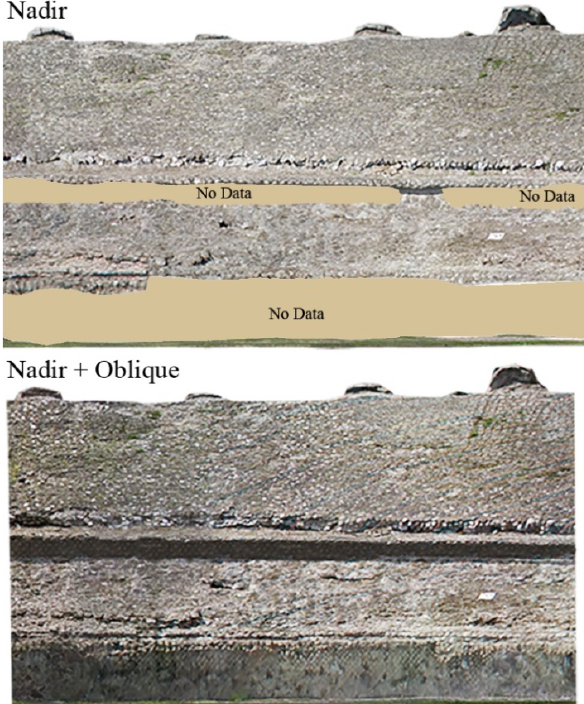
Figure 12: Detail of a section.